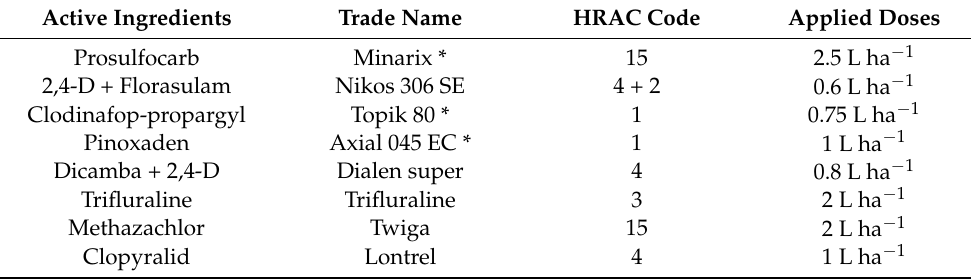
Table 2. Herbicides applied during the two growing seasons. Active